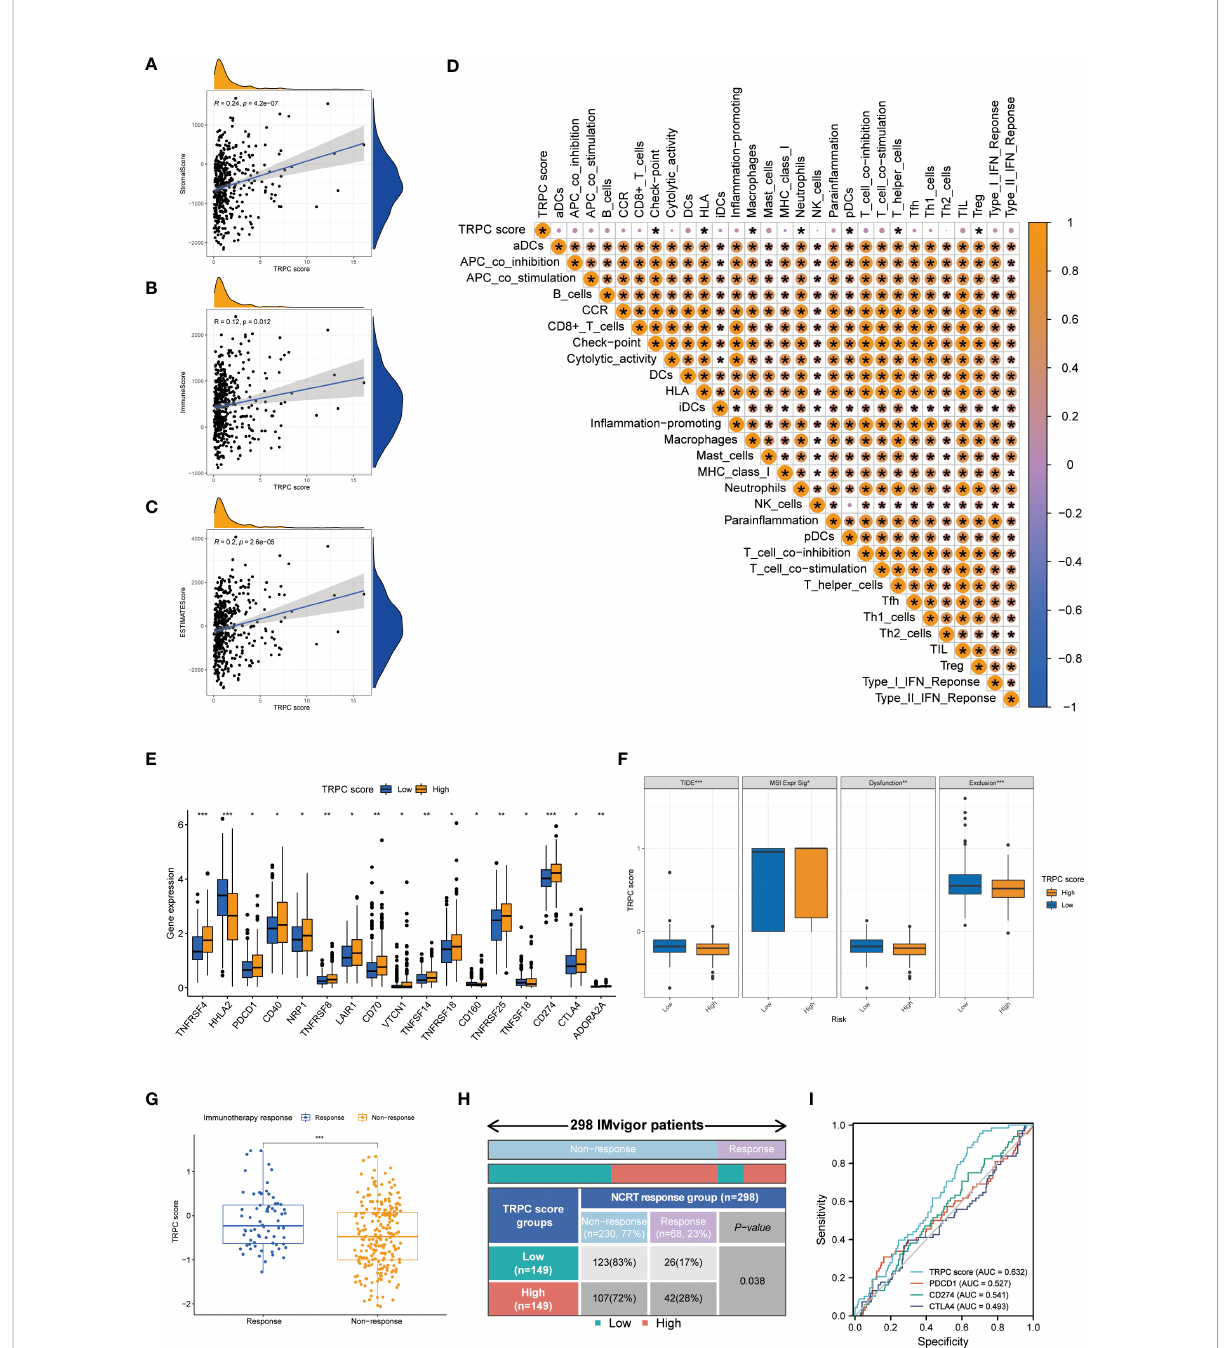
FIGURE 5 Immune landscapes and prediction of immunotherapeutic bene fi ts. Scatter plot showed the association between TRPC score and stromal score (A) , immune score (B) and ESTIMATE score (C, D) Heat map of correlation between TRPC score and immune in fi ltration. (E) The association of the immune check-points between low-and high-TRPC score groups. (F) The differences of TIDE score, MSI expression signature score, dysfunction score and immune exclusion score between low- and high-TRPC score groups. The scatter diagram of the TRPC score between response and non-response group (G) , and fourfold table between TRPC score and immunotherapy response (H) in the IMvigor dataset. (I) ROC curves to predict the response of atezolizumab in IMvigor dataset by TRPC score, PDCD1, CD274, and CTLA4. ESTIMATE: estimation of stromal and immune cells in malignant tumour tissues using expression data; MSI, microsatellite instability; ROC, receiver operator characteristic; TIDE, tumor immune dysfunction and exclusion; TRPC, transient receptor potential channels; ns, not signi fi cant; *P< 0.05; **P< 0.01; ***P<